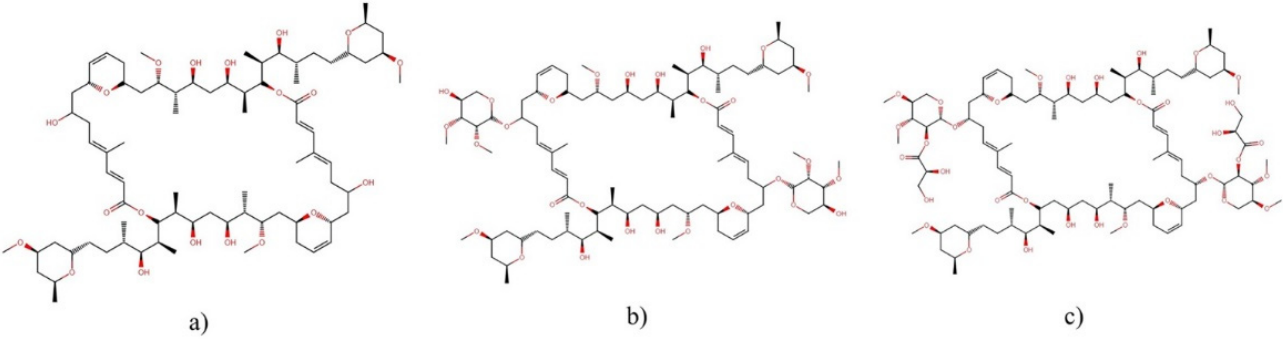
Figure 2. Chemical structures of ( a ) caylobolide A, ( b ) caylobolide B, and ( c ) nuiapolide.